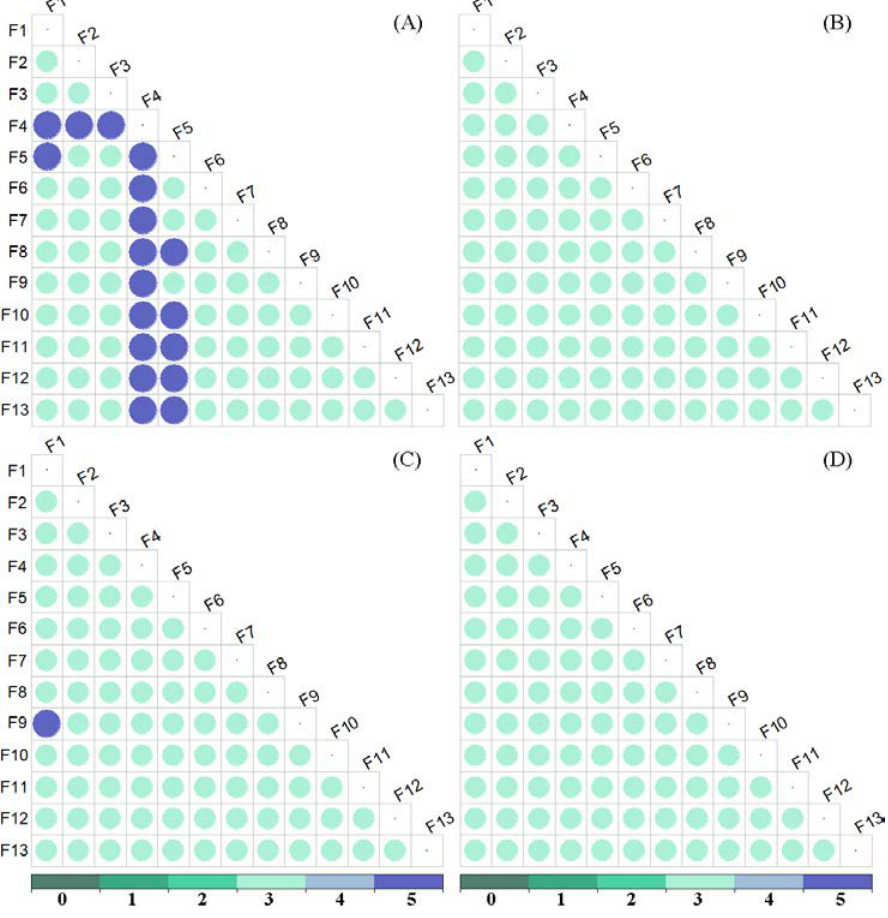
Figure 10. Plot showing results of the interaction detection for ( A ) cage, ( B ) mudflat, ( C ) pond, and ( D ) raft. 0: self-intersection; 1: weaken, nonlinear; 2: weaken, univariate; 3: enhance, bivariate; 4: independent; 5: enhance, nonlinear.